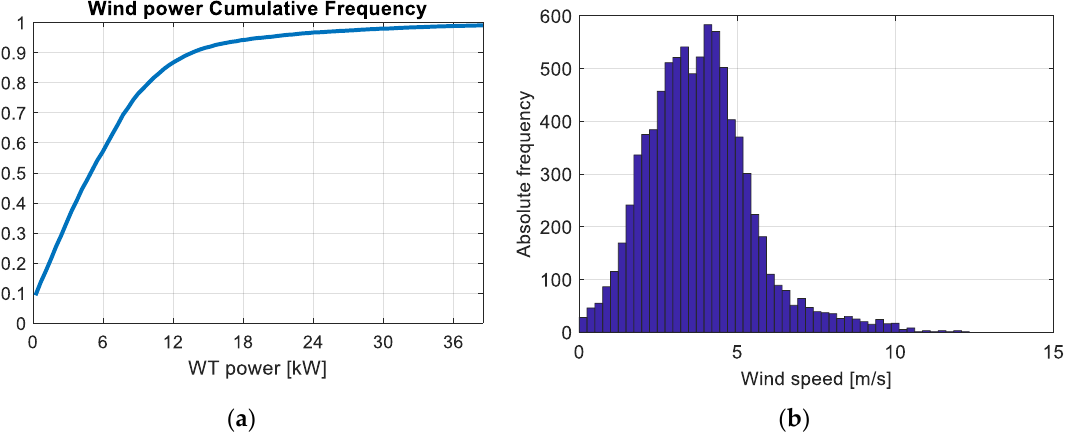
Figure 6. ( a ) Cumulative curve associated with the wind power distribution resulting from applying the model expressed by Equation (3) t o the selected microgrid location (see Table 1); ( b ) Histogram of the yearly wind speed profile.